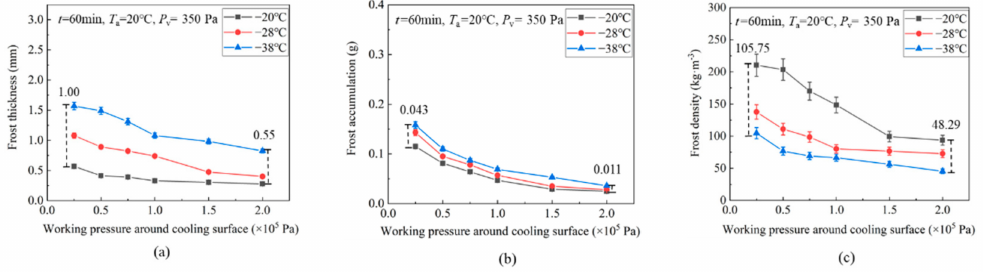
Figure 13. ( a ) Frost thickness; ( b ) frost accumulation; ( c ) frost density with working pressure around cooling surface under different temperatures of cooling surfaces at 60 min.